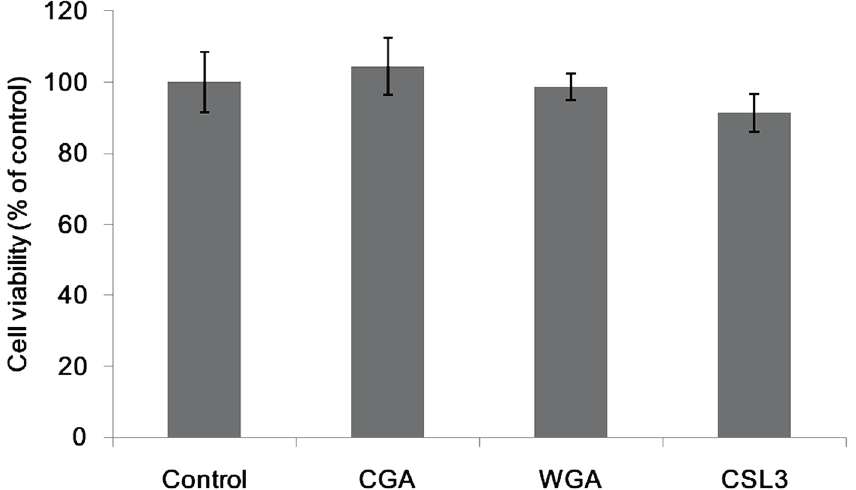
Figure 1. Cytotoxicity of lectins on Caco-2 cells. Cytotoxicity was measured after incubating with lectins (200 µg/mL) for 6 h. Results are shown as a percentage of control (without lectins) values, and are the means ± SD of three different